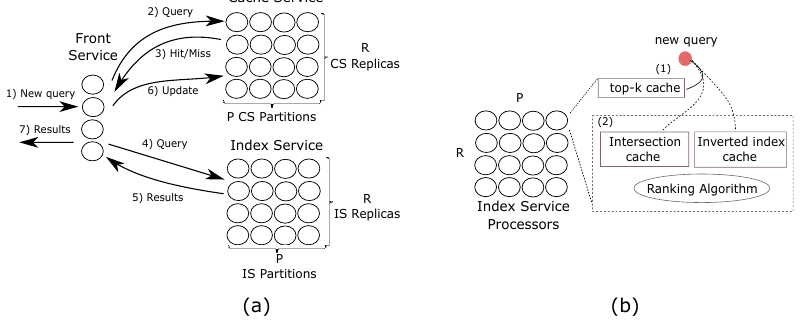
Figure 1. ( a ) Query processing in a WSE and ( b ) inside an index service